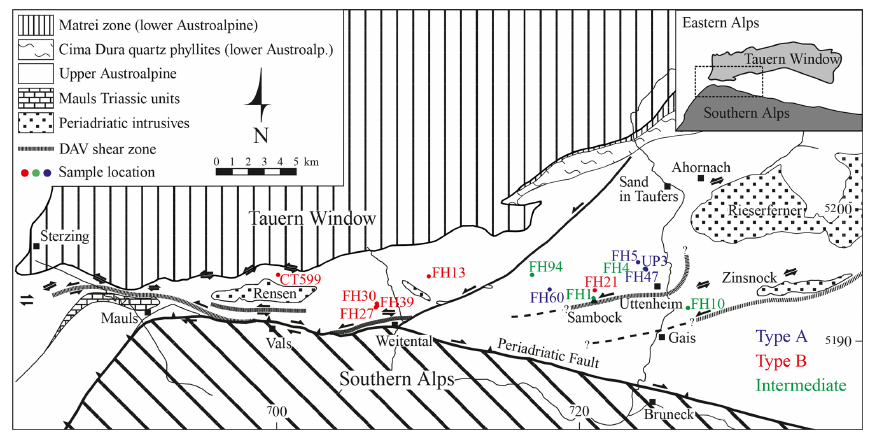
Figure 1. Geologic map of the study area (modified after Mancktelow et al., 2001). The sample numbers are coloured according to the type of albite–quartz matrix (see text and Table